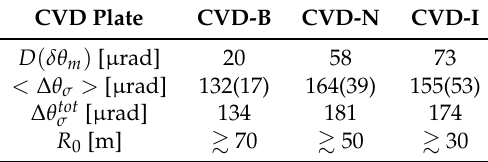
Table 2. Statistical rocking curve characteristics for the regions of interest on selected sc-CVD diamond plates.